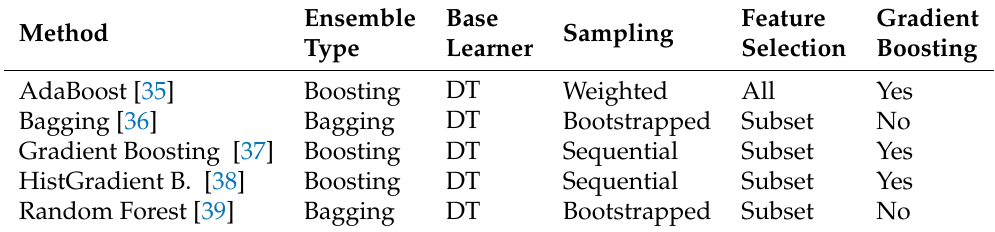
Table 1. Differences between the compared ensemble